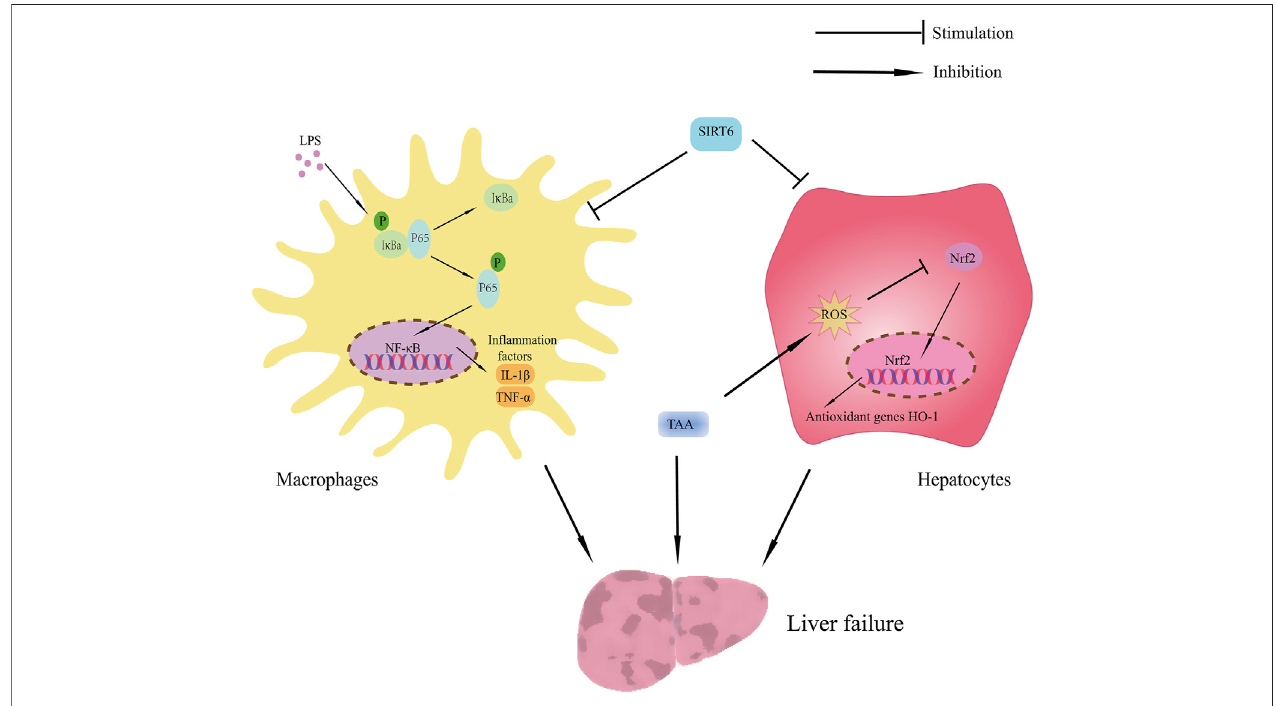
FIGURE 9 | Schematic showing the bene fi t of SIRT6 on TAA-induced ALF mice. The protective effect of SIRT6 includes 1) upregulation of SIRT6 inhibiting in fl ammatory response by suppressing the NF- κ B pathway and 2) upregulation of SIRT6 inhibiting oxidative stress by regulating the Nrf2/HO-1 pathway.